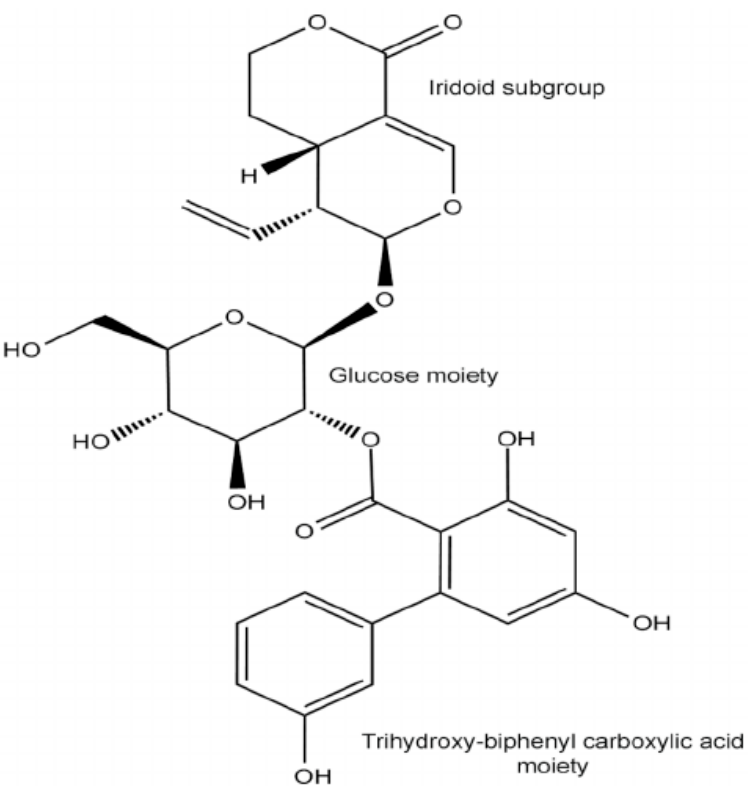
Figure 2. Structure of Amarogentin—a secoiridoid glycoside. Amarogentin consists of three essential subgroups, the iridoid group, the glucose moiety and the biphenyl-triol rings (Source [44,45]).